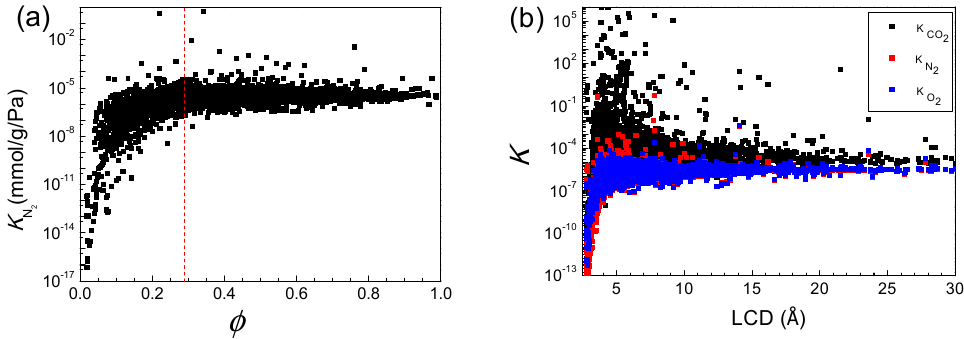
Figure 3. Henry coe ffi cient K N2 versus ( a ) φ and ( b ) Figure 3. Henry coefficient K N2 versus ( a ) ϕ and ( b ) LCD.